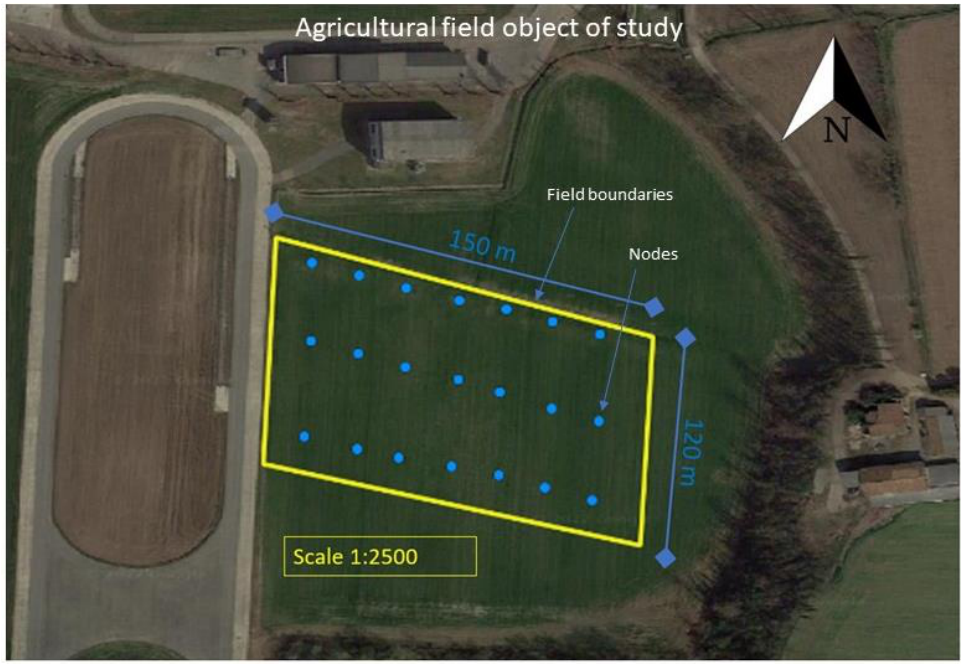
Figure 1. Experimental field of CREA-IT .